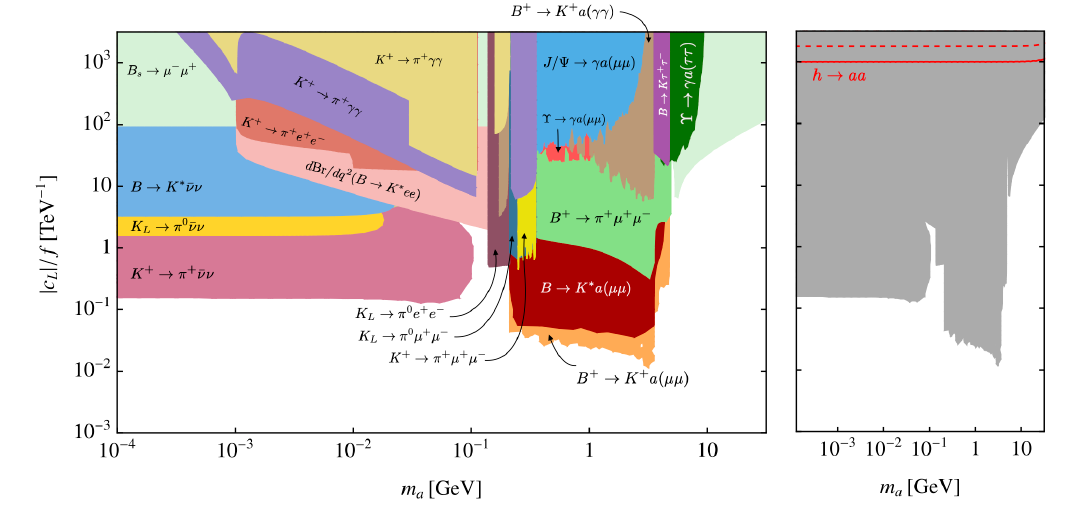
Figure 26 . Left: flavor bounds on universal ALP couplings to lepton doublets with c L = c L 1 , and all other Wilson coefficients zero at the scale Λ = 4 πf and f = 1 TeV. Right: contours of constant Br ( h → aa ) = 10 − 1 , 10 − 2 and 10 − 3 are depicted as red dotted, dashed and solid lines, respectively. Contours of constant Br ( h → Za ) = 10 − 1 and 10 − 2 are shown as blue dashed and solid lines,